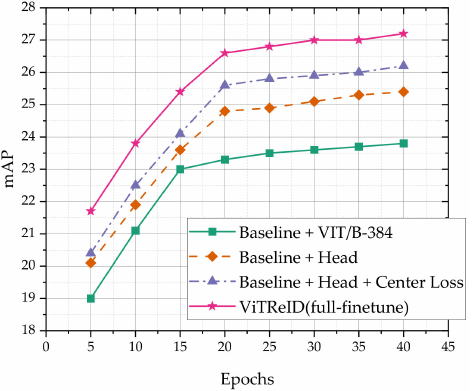
Figure 3. mAP change of Market1501 → MSMT17.